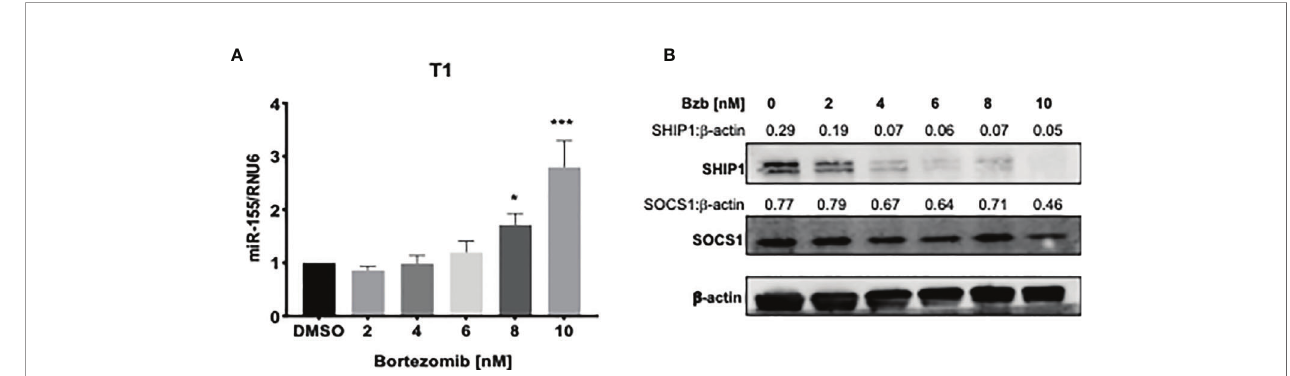
FIGURE 4 | Dose dependent increase of miR-155 expression and decrease of SH-2 containing inositol 5 ’ -polyphosphatase 1 (SHIP1) protein following bortezomib treatment. Human lymphoblast T1 cells were treated in vitro for 24 h with increasing concentrations of bortezomib (2, 4, 6, 8, 10 nM). The cells were collected and analyzed for miR-155 expression by RT-PCR and for suppressor of cytokine signaling 1 (SOCS1) and SHIP1 protein levels by Western blotting. (A) The expression of miR-155 in T1 cells is shown upon bortezomib treatment at the indicated concentrations. (B) SOCS1 and SHIP1 protein levels in T1 cells upon bortezomib treatment at the indicated concentrations. Control samples are treated with DMSO. Numbers above the bands are the indicated ratios of the densitometry values. Data in bar graphs are presented as mean values ± SEM from fi ve independent experiments, each with triplicate values. * p < 0.05, *** p < 0.005 compared to DMSO controls (Unpaired t -test, two